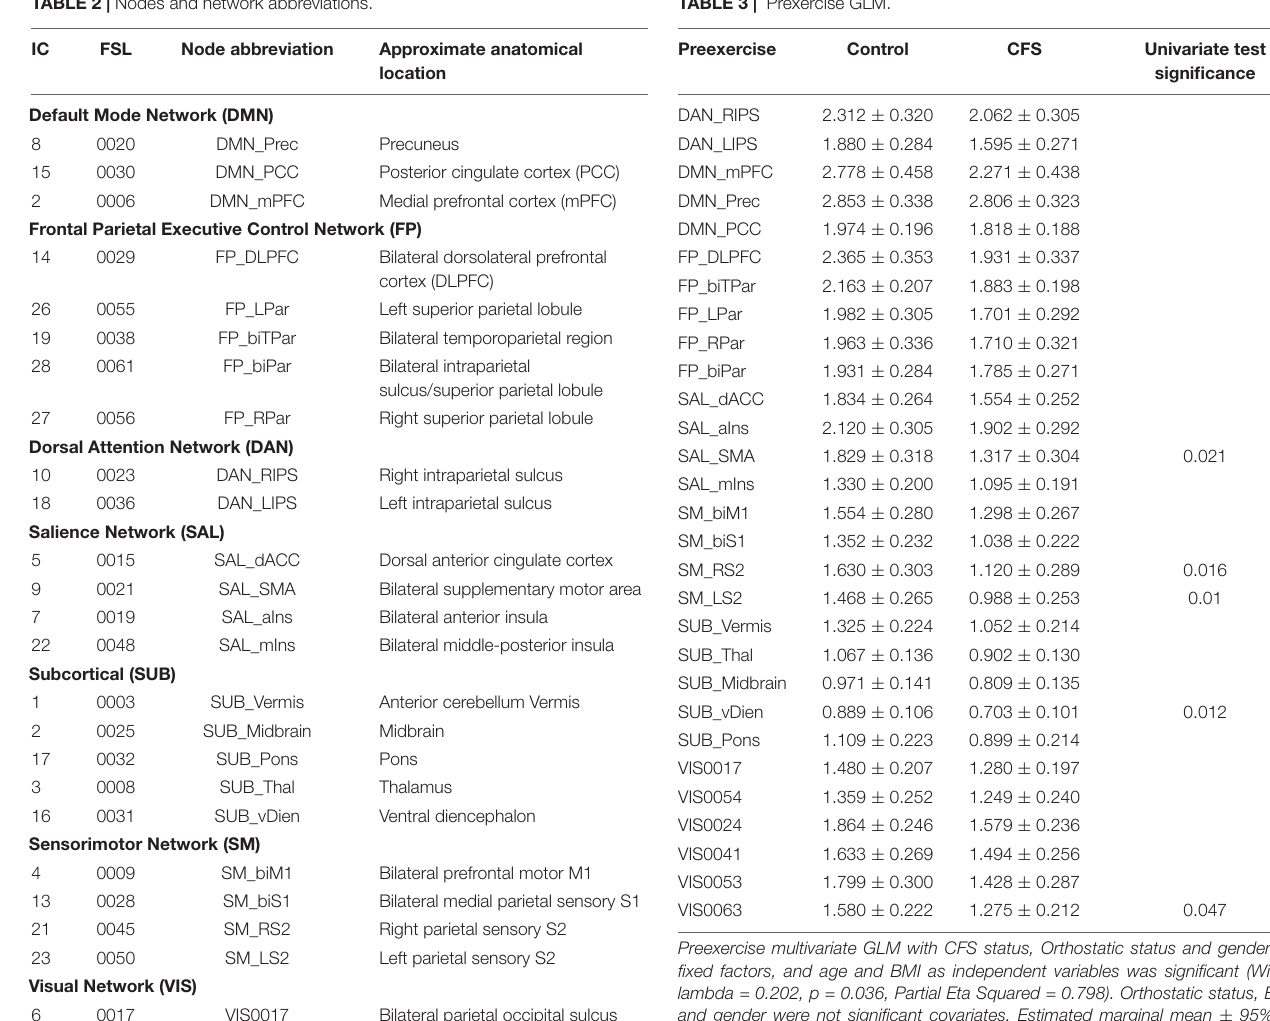
TABLE 2 | Nodes and network abbreviations. TABLE 3 | Prexercise